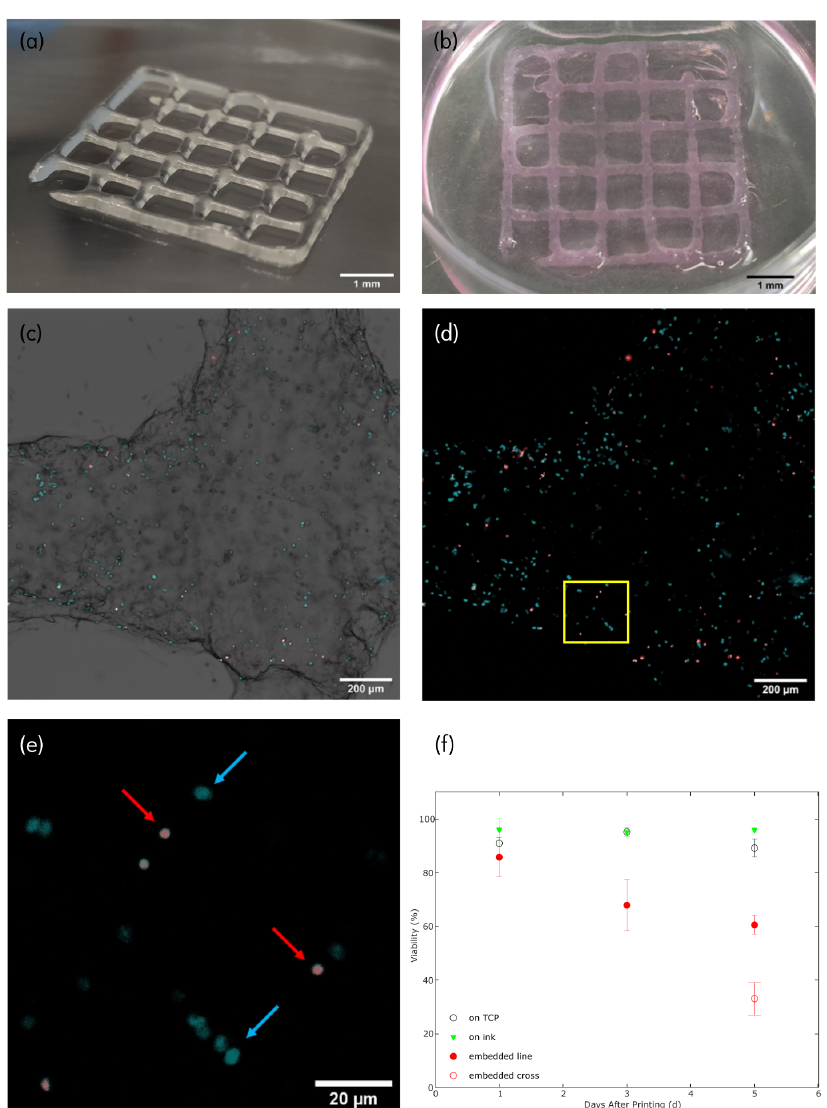
Figure 2. ( a ) Photograph of a 3D-bioprinted construct directly after printing and submersion for 5min in a corresponding TG crosslinking solution. Ink contains NIH 3T3 cells. A photograph of a non crosslinked construct directly after printing can be found in the Supplementary Data (Figure S1a, scale bar = 1mm; ( b ) Photograph of a 3D-bioprinted construct five days after printing and incubation at 37 °C, ink contains NIH 3T3 cells, scale bar = 1mm; ( c ) Fluorescence microscopy image of 1 d postprint construct stained with Hoechst 33342 (blue) and PI (red), stacking of BF, Hoechst and PI channel, scale bar = 200 µ m; ( d ) Fluorescence microscopy image of 1 d post-print construct, stacking of Hoechst and PI channel only, scale bar = 200 µ m; ( e ) Zoom into fluorescence microscopy image of 1 d post-print construct. Blue arrows indicate Hoechst 33342 staining of cell nucleus (live cell), while red arrows indicate PI staining of cell nucleus (necrotic cell), scale bar = 20 µ m ( f ) Graphic cell viability illustration of cells seeded on tissue culture plate (TCP, control I, empty black circle), of cells seeded onto previously 3D-printed constructs (control II, green triangle) and cells 3D-bioprinted within the bioink (red circles). Additionally, on day 5, the viability is split into viability in crossing structures (empty red circle) and viability in ’line’ structures (full red circle), all with corresponding error